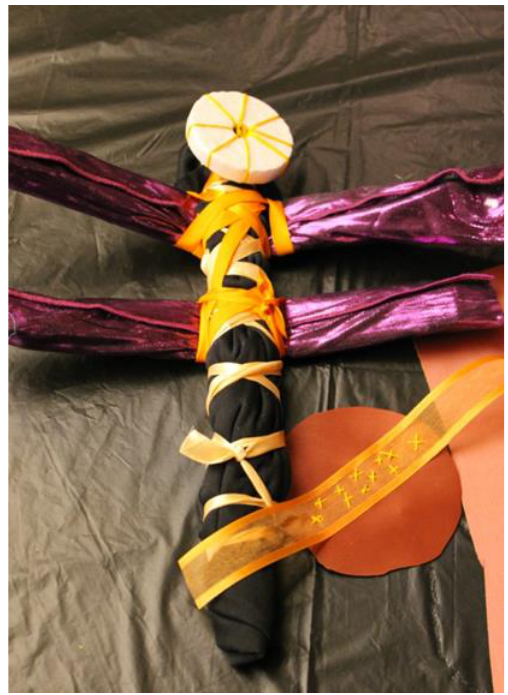
Figure 3. R and F create a dragonfly in an open studio in a shelter/community